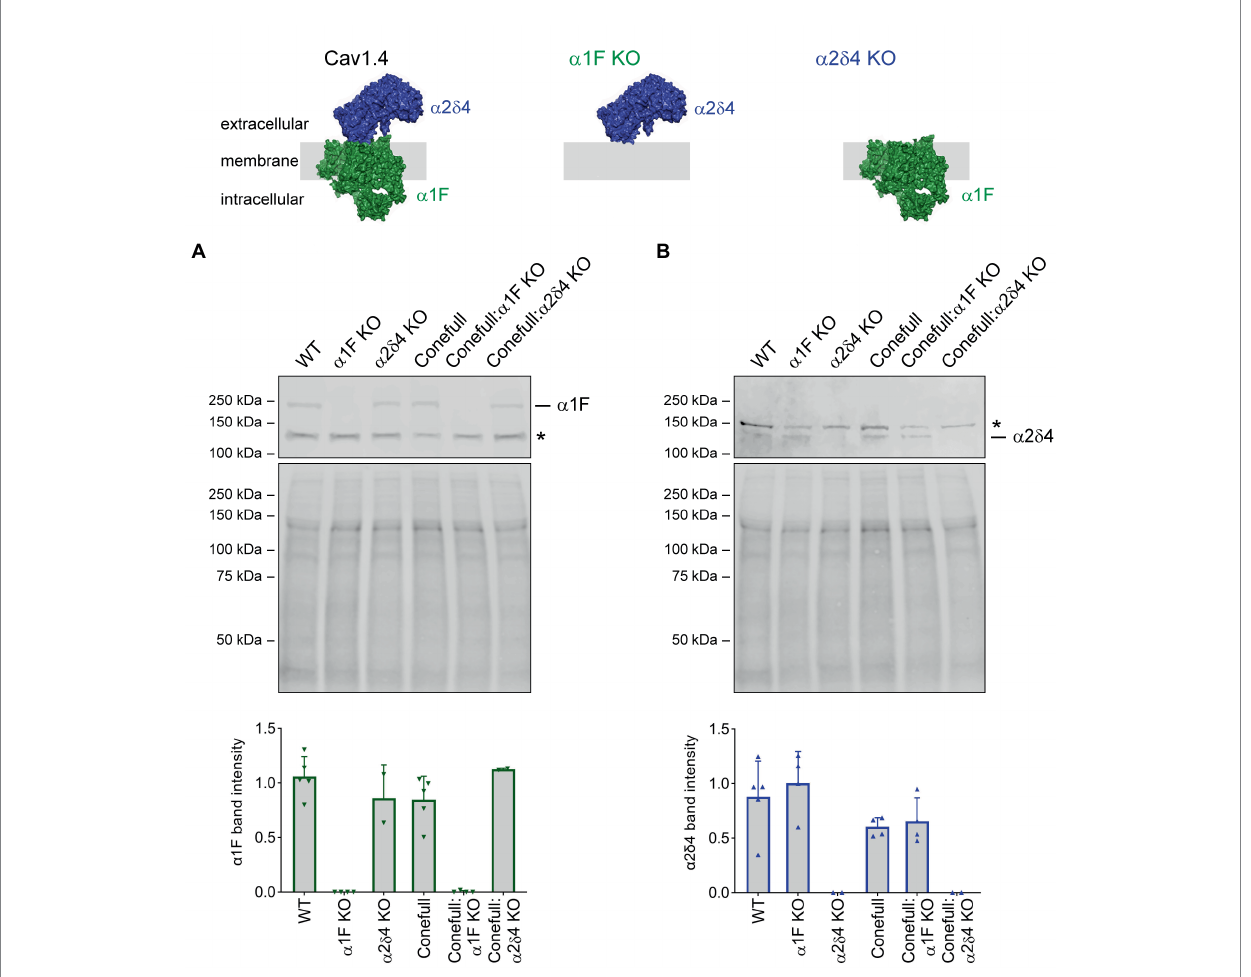
FIGURE 1 Validating loss of the respective Cav1.4 subunits in the new Conefull strains. Cartoons of Cav1.4 illustrating the knockouts used in this study. The cartoons were drawn using the structure of Cav1.3 (PDB ID 7UHG) as reference. (A) Western blot for α 1F, specific band is at 230 kDa, the asterisk indicates a non-specific signal. Mid-panel is total protein stain used for normalization as shown in the lower graph, bars are S.D. (B) Western blot for α 2 δ 4, specific band is at ~130 kDa, the asterisk indicates a non-specific signal. Mid-panel is total protein stain used for normalization as shown in the lower graph, bars are